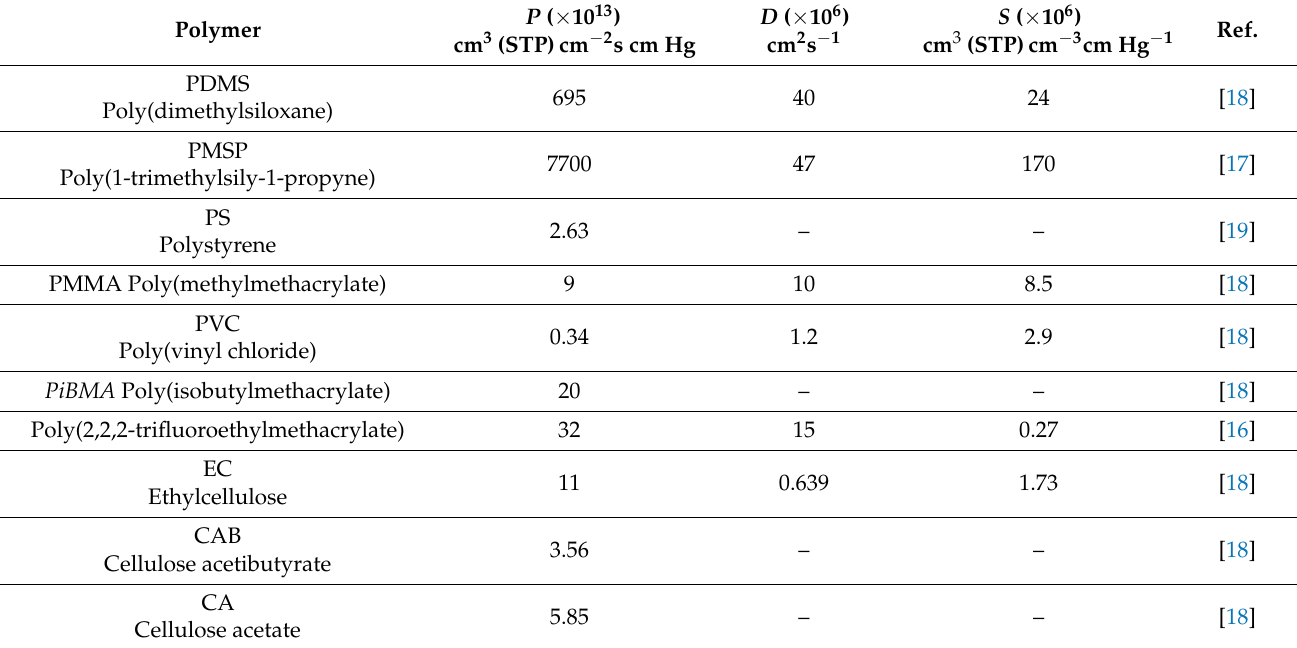
Table 1. Polymer proprieties (permeability, diffusion, and